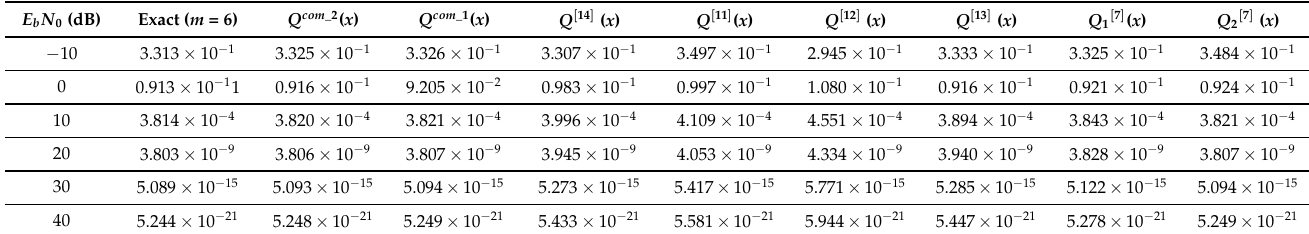
Table 5. Comparison of ASEP values over Nakagami- m fading channels for parameter m = 6, obtained by applying our Q -function approximations and selected ones from the literature.